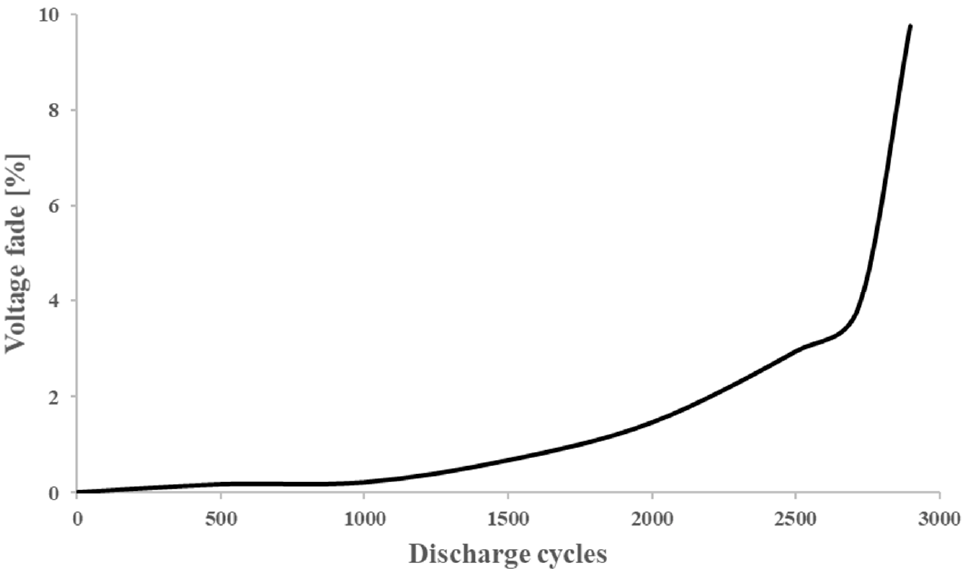
Figure 9. Nissan leaf second life battery voltage fade in various discharge cycles [22,29–31].